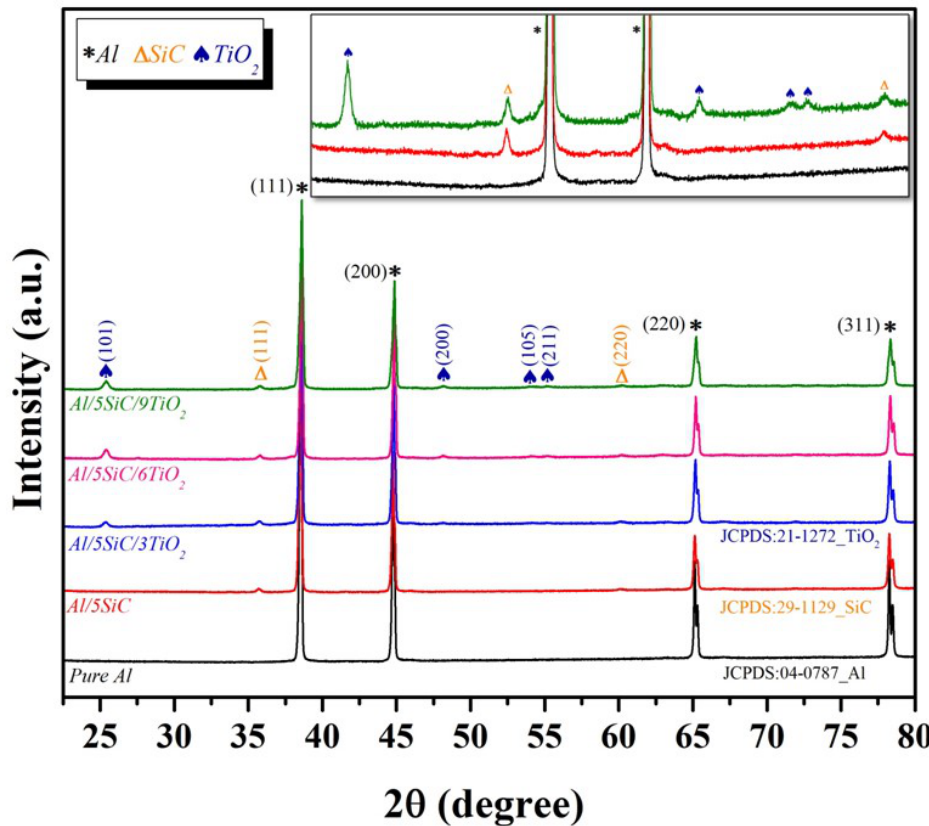
Figure 3. XRD pattern of the Al/SiC/TiO 2 hybrid nanocomposites (inset: magnification image of the pure Al, Al-5SiC, and Al-5SiC-9TiO 2 scale from 20° to 62°).